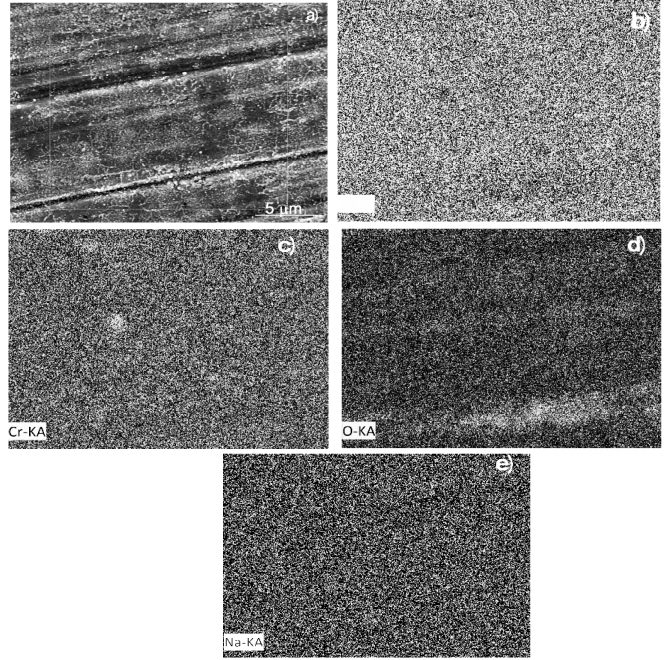
Figure 8. SEM micrograph of T91 steel corroded in 60 wt% NaNO 3 -40KNO 3 at 300 °C showing ( a ) secondary electrons image and EDX mappings of ( b ) Fe, ( c ) Cr, ( d ) O and ( e ) Na.